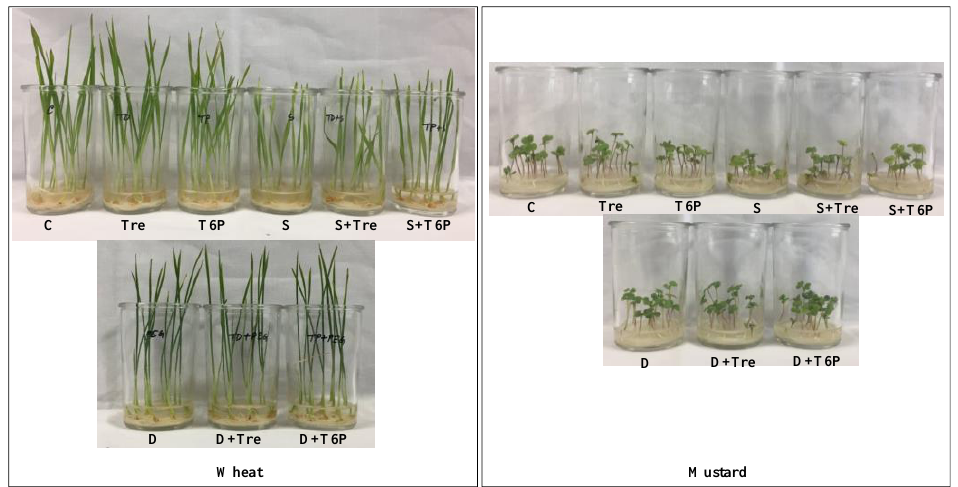
Figure 1. Effect of trehalose and T6P on the appearance of wheat and mustard seedlings. Wheat seedlings were grown in a hydroponic solution containing 300 mM NaCl for 9 days. Mustard seedlings were grown in 200 mM NaCl for 10 days. For water deficit treatment, wheat seedlings were treated with 20% PEG, while mustard was treated with 12% PEG for four days. C, control; Tre, 200 µM trehalose; T6P, 200 µM trehalose 6-phosphate; S, NaCl treatment; D, water deficit treatment with PEG 6000.